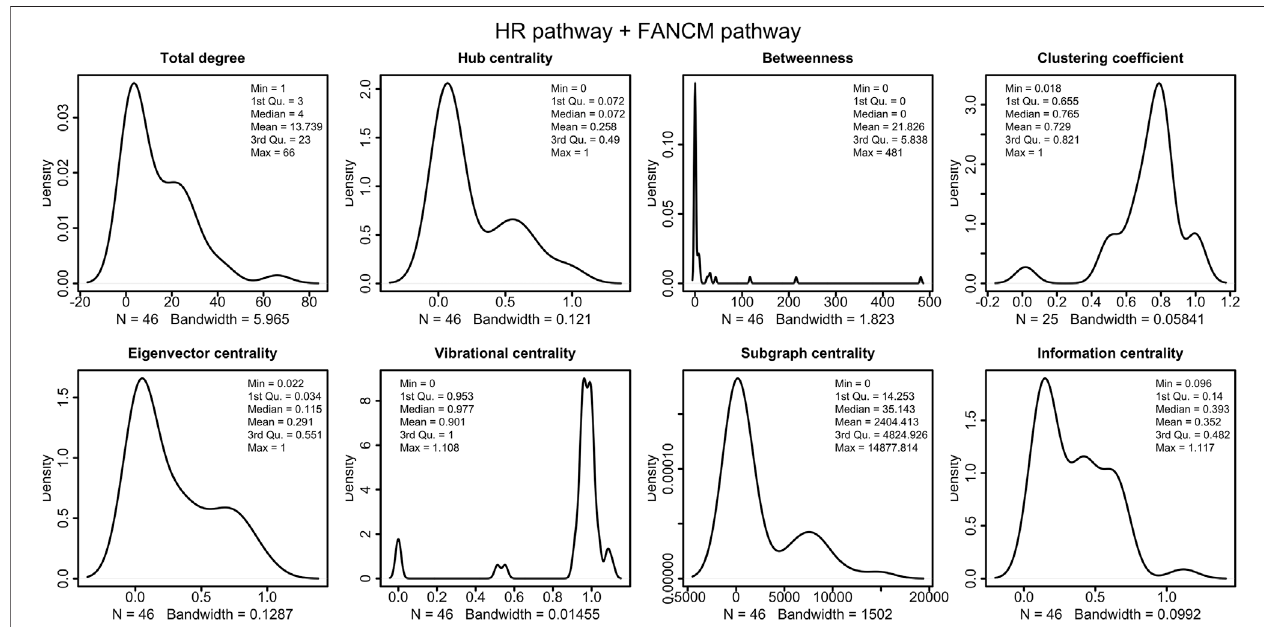
FIGURE 9 | Distributions of the centrality measures of HR pathway (Orlic-Milacic, 2015) merged with FANCM pathway (Pathways Commons, 2022). We observe that the majority of node have low betweenness, and high vibrational centrality.